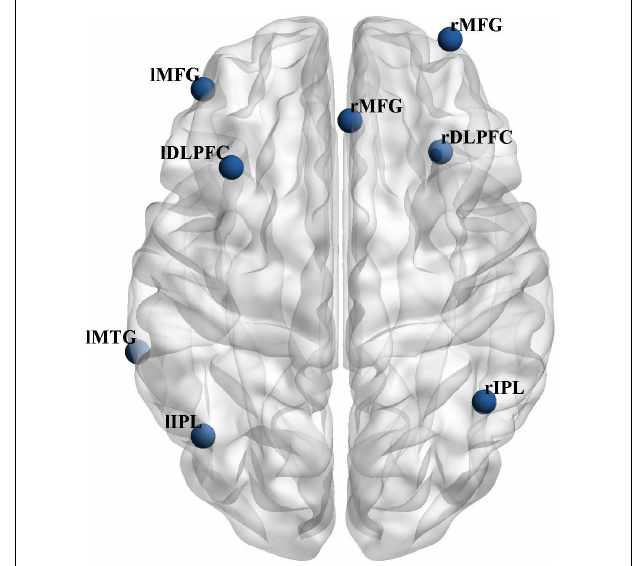
FIGURE 1 | Location of the bilateral ECN